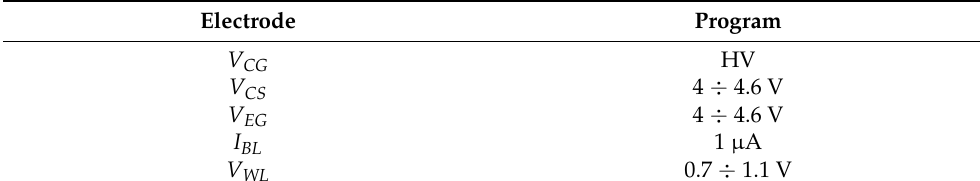
Table 1. Bias conditions in ESF3 program operation [19–23].